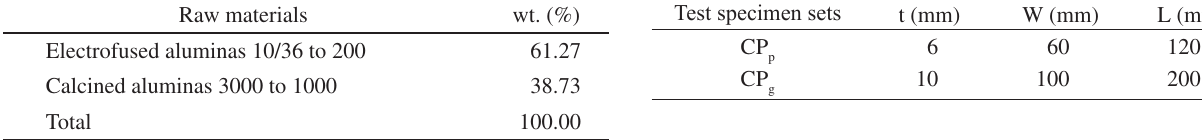
Table 2. Dimensions of the test specimens. Test specimen sets